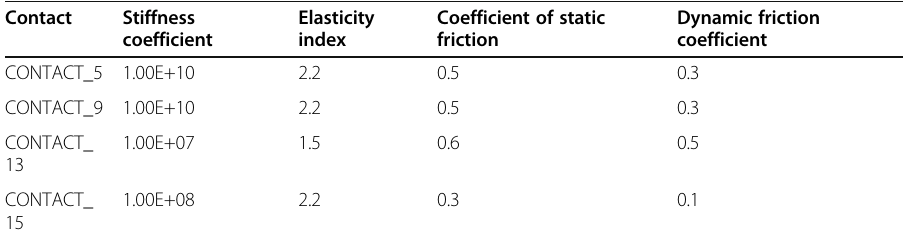
Table 2 Parameter values set by the model Contact